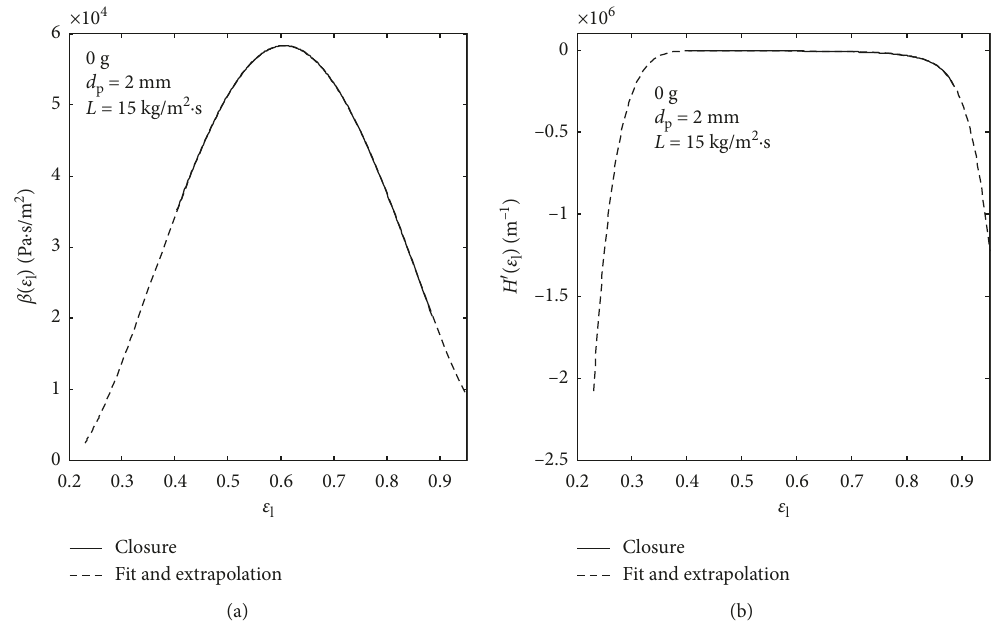
Figure 1: (a) Sample fit and extrapolation of the β function (air/water). (b) Sample fit and extrapolation of the H